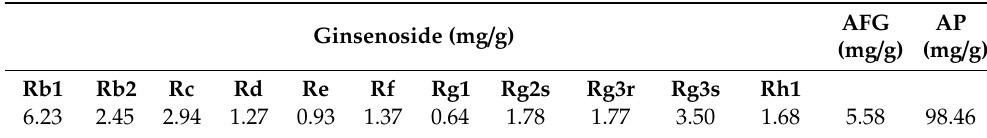
Table 1. Characterization of red ginseng